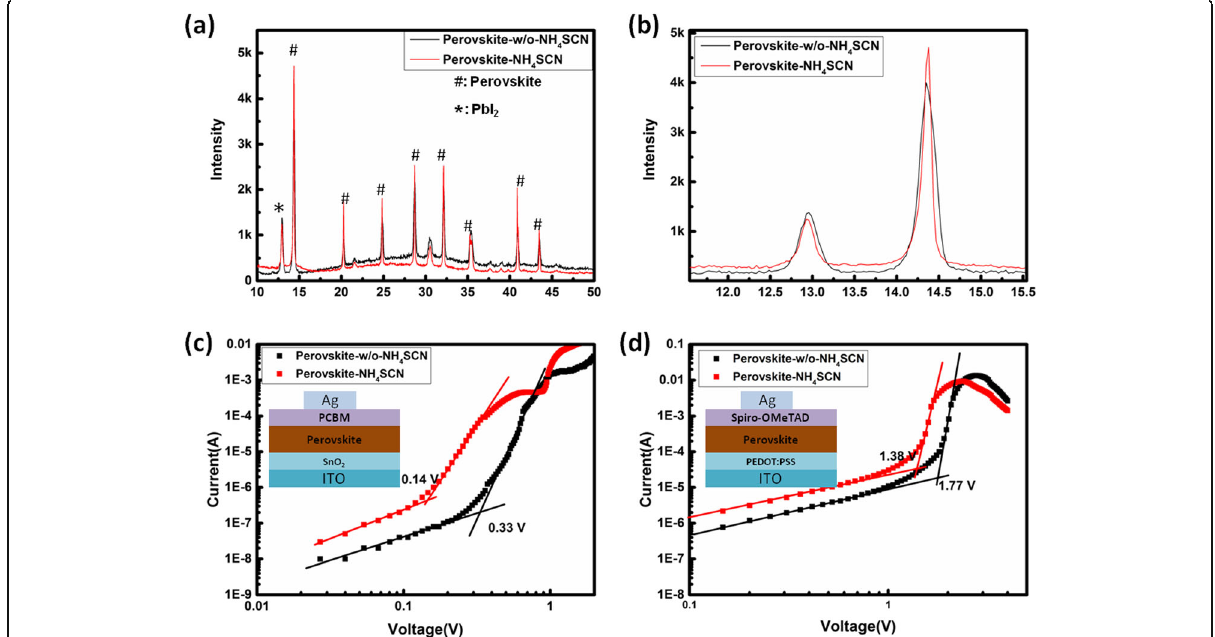
Fig. 5 a XRD patterns of perovskite-w/o-NH 4 SCN films and perovskite-NH 4 SCN films. b Magnified XRD patterns at a range of 12 – 15°. c dark I-V curves for electron-only devices based on different perovskite films (inset: configuration of electron-only devices). d Dark I-V curves for hole-only devices based on different perovskite films (inset: configuration of hole-only